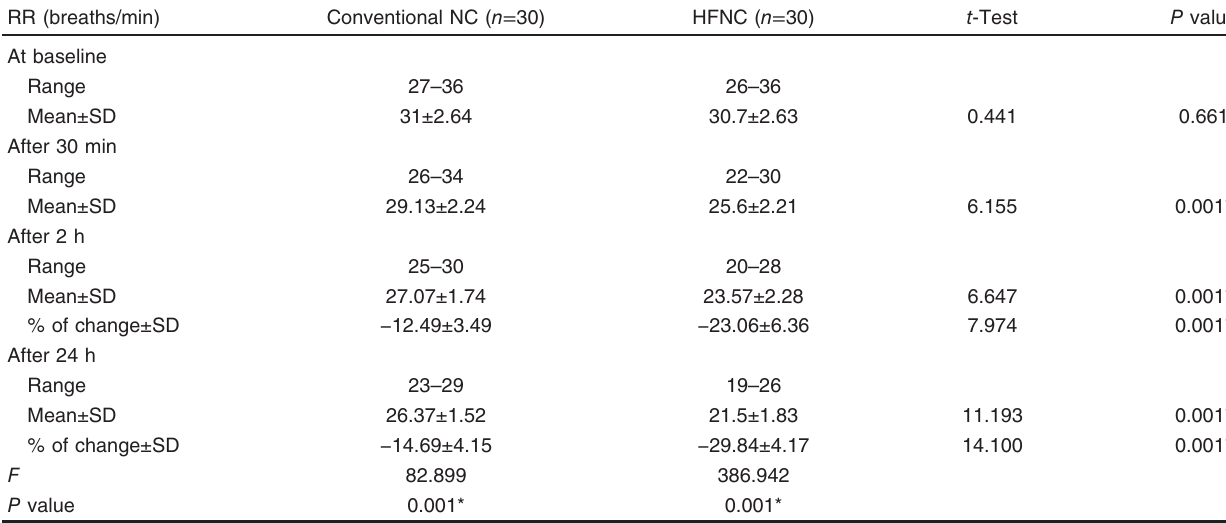
Table 4 Comparison of respiratory rate between the two studied groups RR (breaths/min) At